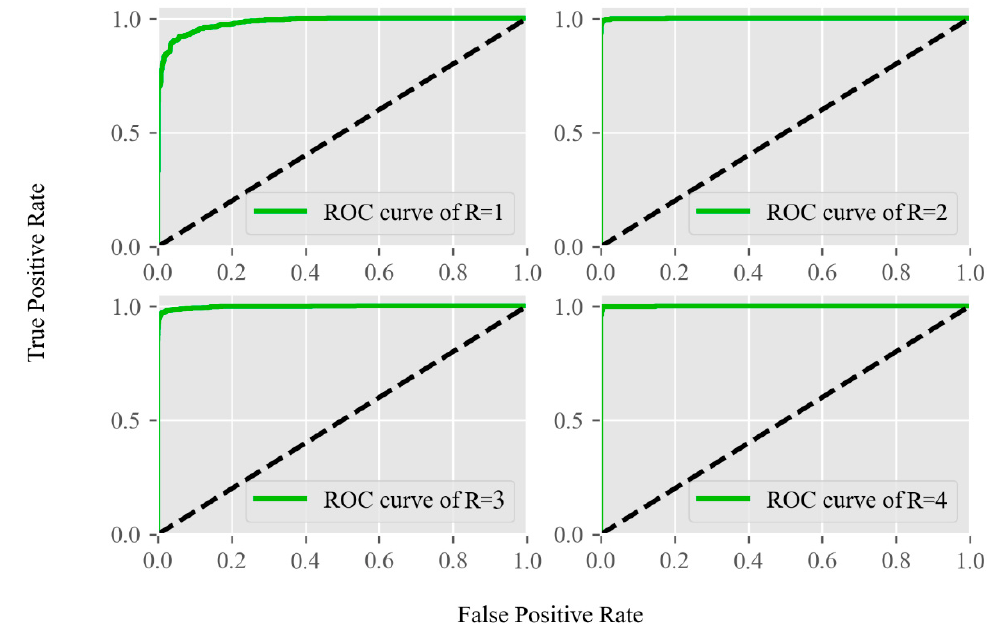
Figure 6. The ROC of the proposed recognition model on different resolution ratios of the RSSCN7 dataset.